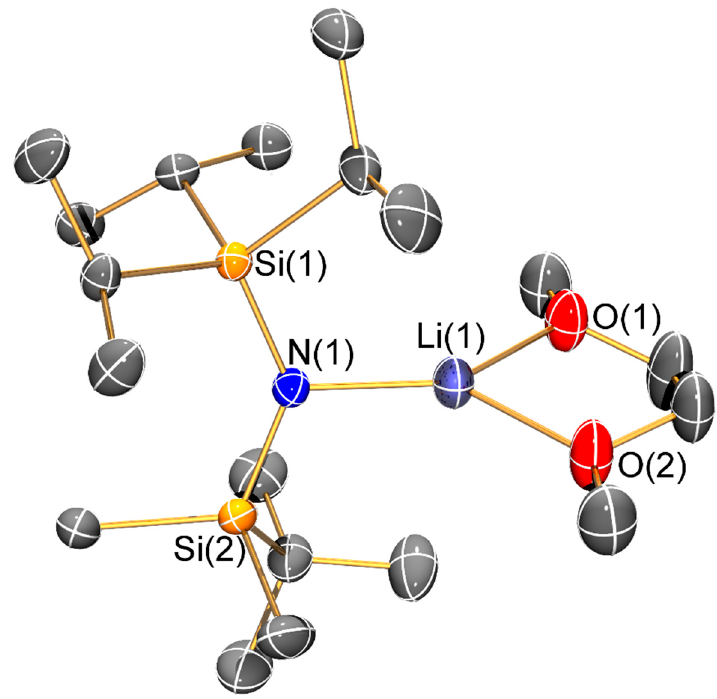
Figure 6. Molecular structure of [Li{N(Si i Pr 3 )(Si t BuMe 2 )}(DME)] ( 6 ) with selective atom labelling. Displacement ellipsoids set at 30% probability level and hydrogen atoms omitted for clarity.